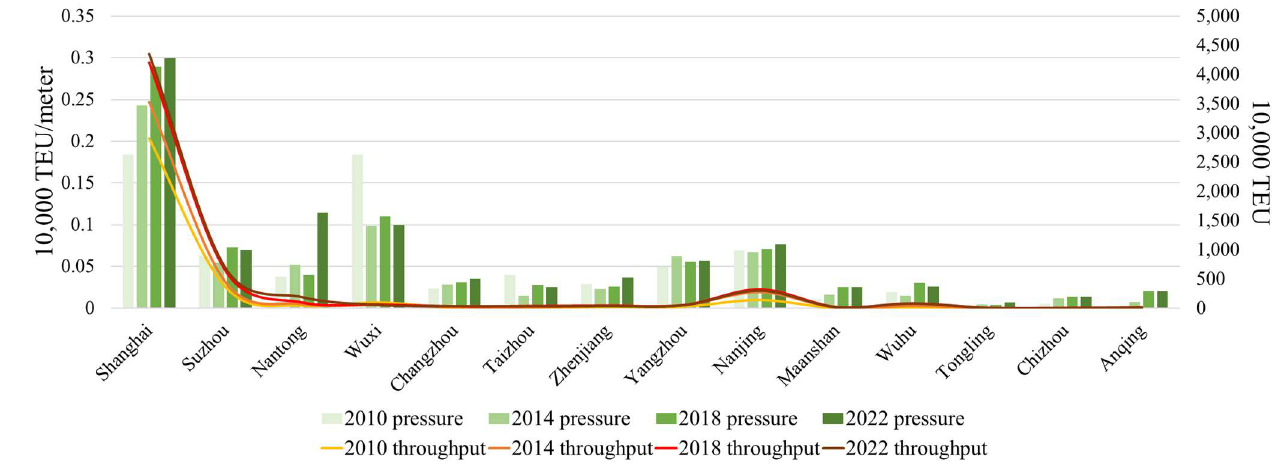
Figure 7. Container port waterfront pressure and container throughputs.